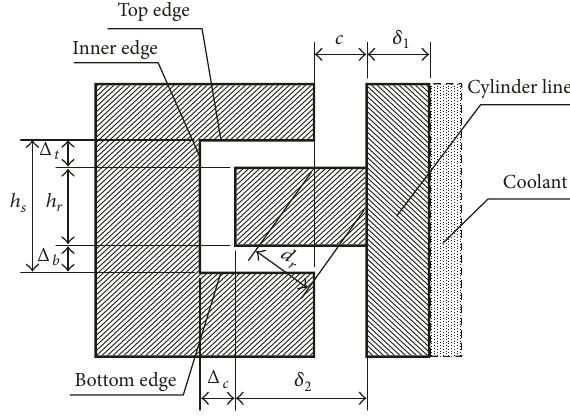
Figure 6: Structure of piston ring groove